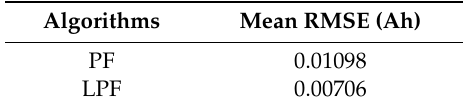
Figure 12. Comparison of capacity estimate RMSEs for battery B18 between the PF and the LPF methods. Table 4. Mean RMSE of One-Step-Ahead Capacity